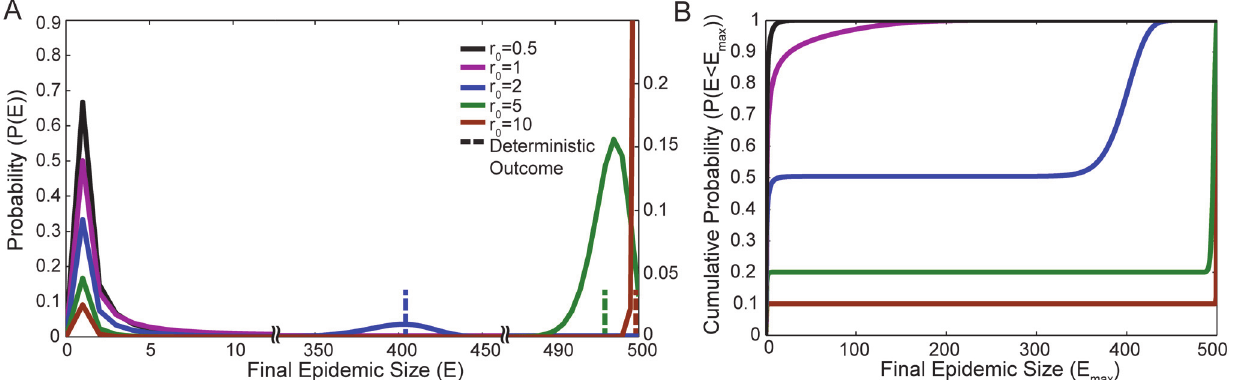
Fig 1. Epidemic size distribution. Figure A illustrates the final epidemic size distributions P ( E ) for various values of r 0 in the stochastic SIR model. The corresponding result for the deterministic SIR model (a number E ) is marked in each case by a dashed line. The left vertical scale in Figure A describes the small terminal infections (left of the first horizontal scale break), and the right vertical scale describes large-scale infections (right of the first horizontal scale break). Figure B illustrates the corresponding cumulative probability distribution P ( E < E max ) or the probability of an epidemic of size less than E max . This also shows the relative weight in the terminal infection and in the large-scale epidemic. In each case N = 500 and I 0 =